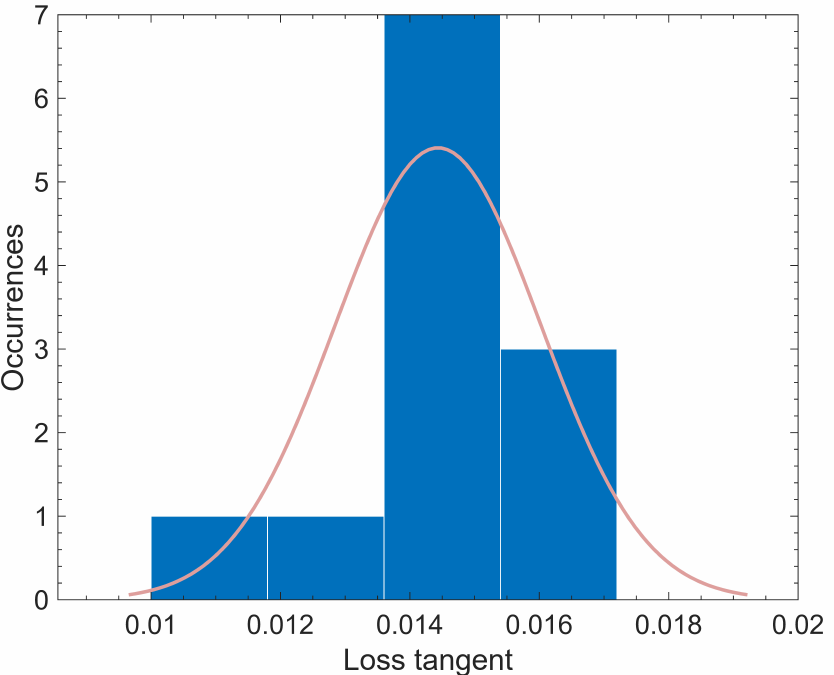
Figure 6. Histogram of the calculated loss tangent in the lunar regolith at the Chang’E-5 landing